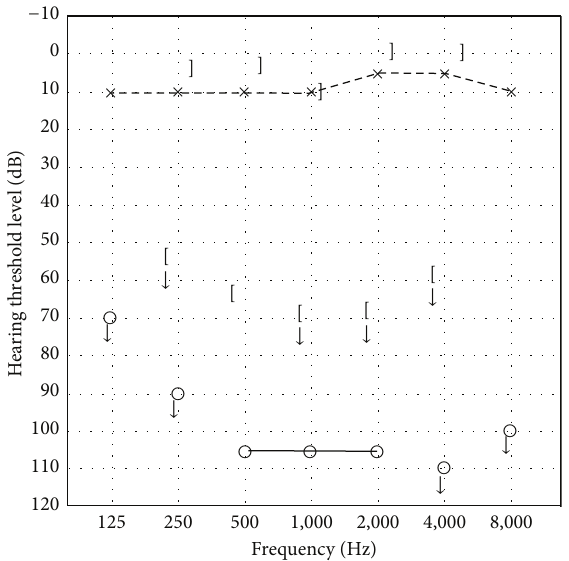
Figure 1: Audiogram on hospital on day 1. The right ear showed profound sensorineural hearing loss.